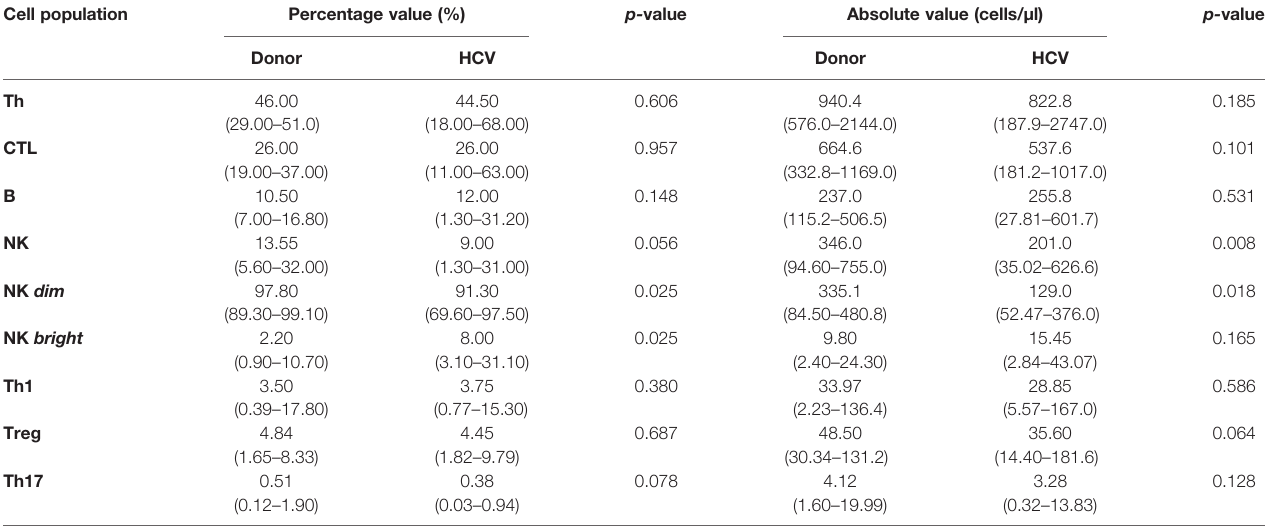
TABLE 3 | Quanti fi cation of peripheral cell